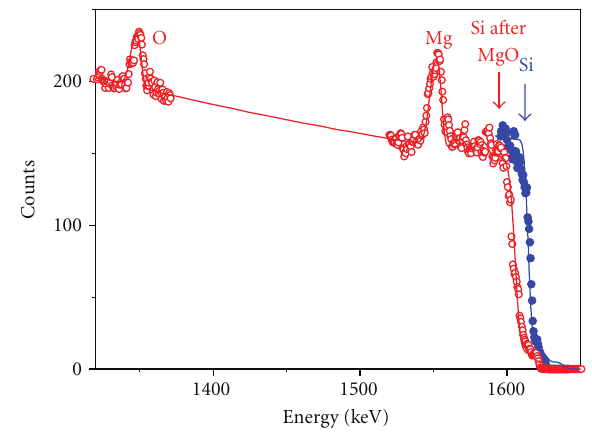
Figure 8: Sub-nanometer thick MgO: HRBS spectra before and after MgO evaporation. HRBS spectra at the Si edge before MgO evaporation (solid circles) and RUMP simulation (solid line) of the clean Si. After MgO evaporation: HRBS spectra at the Si, Mg, and O edges (open circles) and RUMP simulation (solid line) of the 7.7 ML thin MgO layer as prepared on the Si (100)